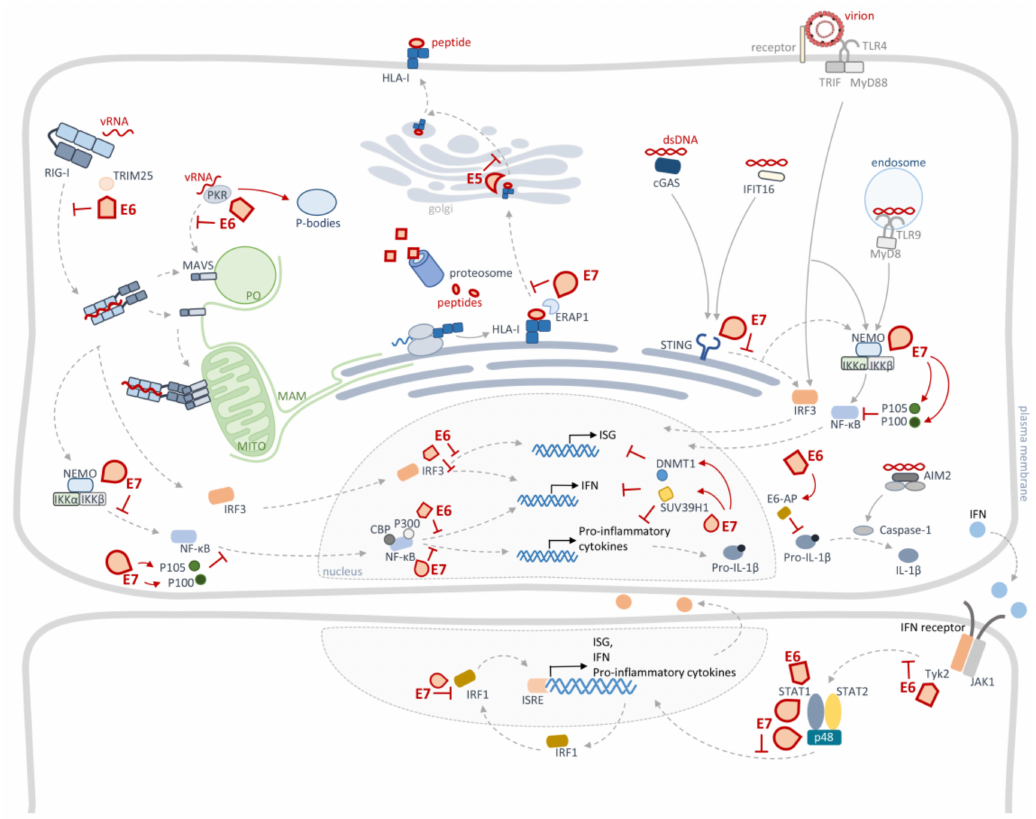
Figure 3. Evasion of the cellular innate immunity response by HPV proteins. HPV E2, E5, E6 and E7 target several steps of the pattern-recognition receptors (PRRs) signalling, downregulating the expression of interferons (IFNs), pro-inflammatory cytokines and IFN-stimulated genes (ISGs), and consequently inhibiting the cellular antiviral response, as well as antigen presentation at cell